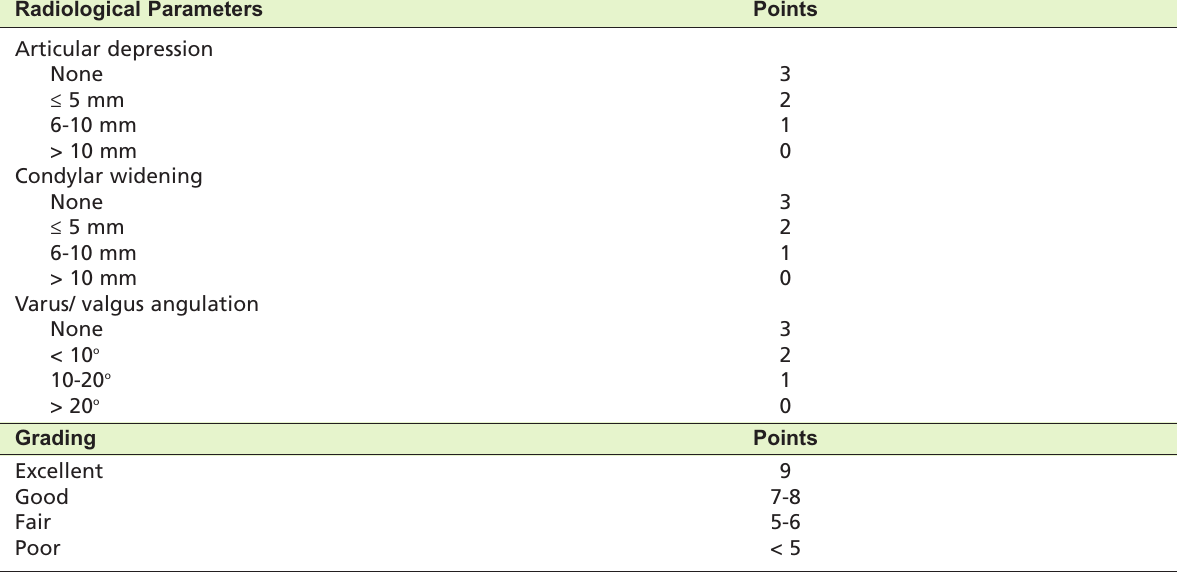
Modified Rasmussen criteria for radiological assessment Table II: